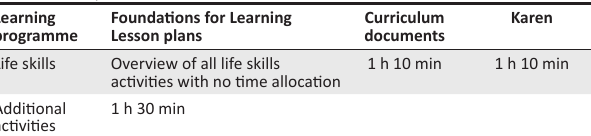
TABLE 1: Comparison of the allocation of times in different sources in Karen’s